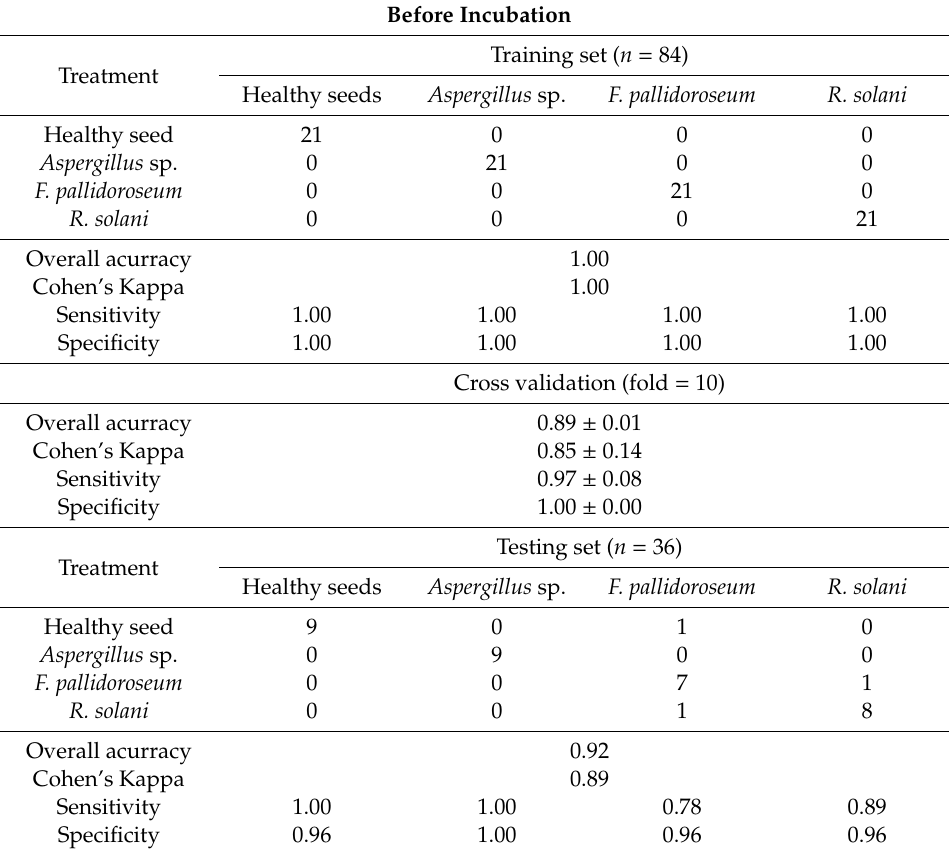
Table 1. Confusion matrices of the LDA model in training and testing set using reflectance, color and texture features of cowpea seeds at 19 wavelengths (365 to 970 nm) for class membership of healthy seed and inoculated seed with Fusarium pallidoroseum, Rhizoctonia solani and Aspergillus sp. Before Incubation Training set ( n = 84) Treatment Healthy seeds Aspergillus sp. F.